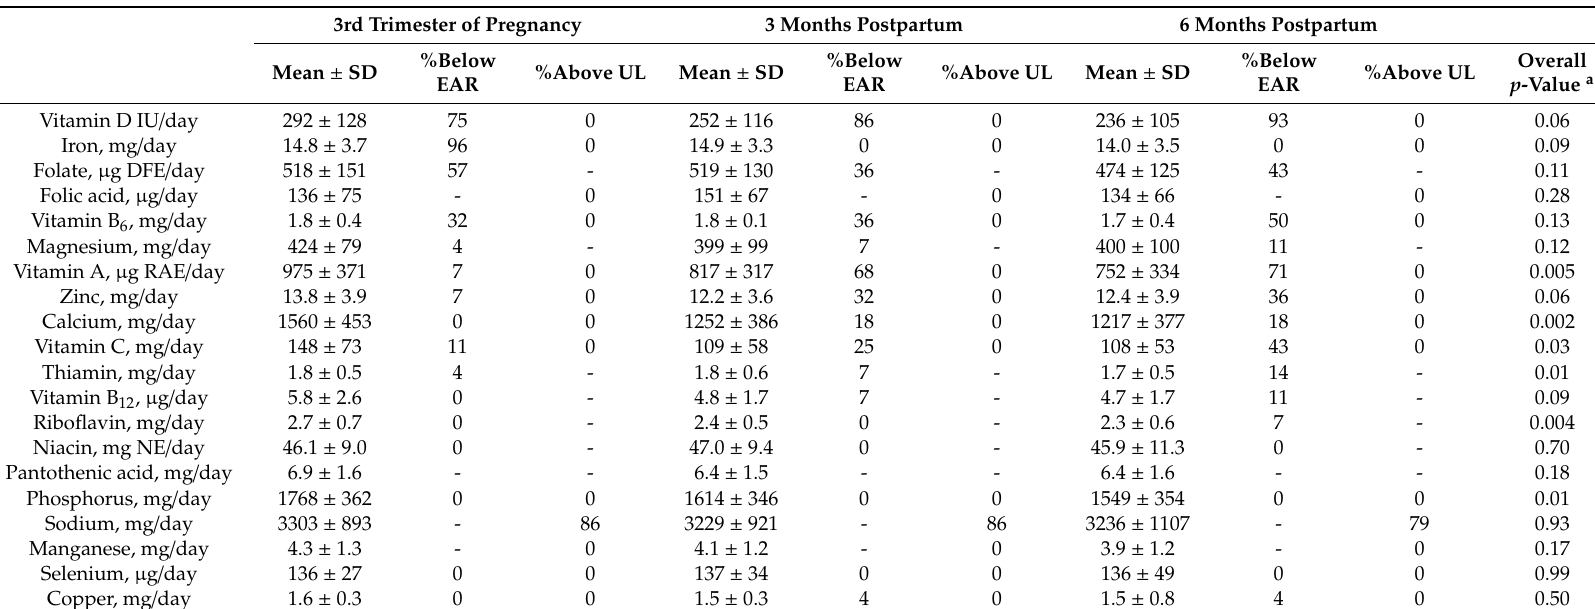
Table 3. Period-specific micronutrient intake from food alone in comparison with dietary reference